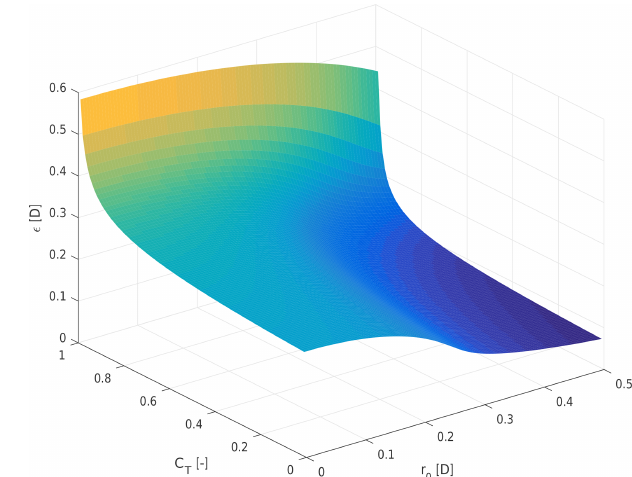
Figure 2. Visualization of the width of the double-Gaussian func- tion (cid:15) at the stream tube outlet, as a function of the thrust coefficient C T and the position of the Gaussian extrema r 0